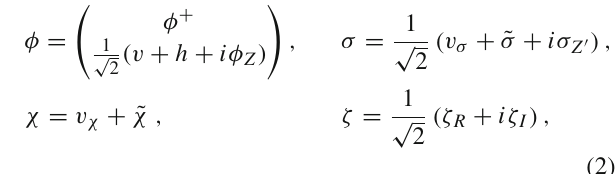
Table 1 Particle charge assignments under the SU ( 3 ) C ⊗ SU ( 2 ) L ⊗ U ( 1 ) Y ⊗ U ( 1 ) B − L ⊗ Z 4 symmetry. Starting with the SM Higgs boson doublet φ ,thescalarsectoriscollectedinthelastfourcolumns,preceded